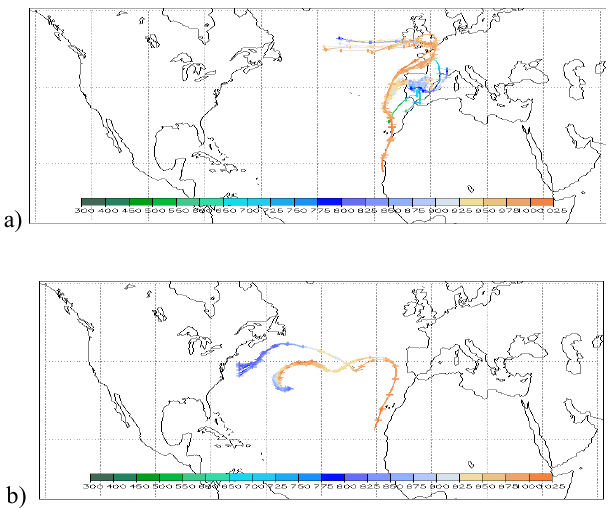
Figure 3. Five-day air mass back trajectories for 19 July (a) and 3 August 2006 (b) . The color indicates the pressure level (hPa).